Question: Write the caption for this figure.
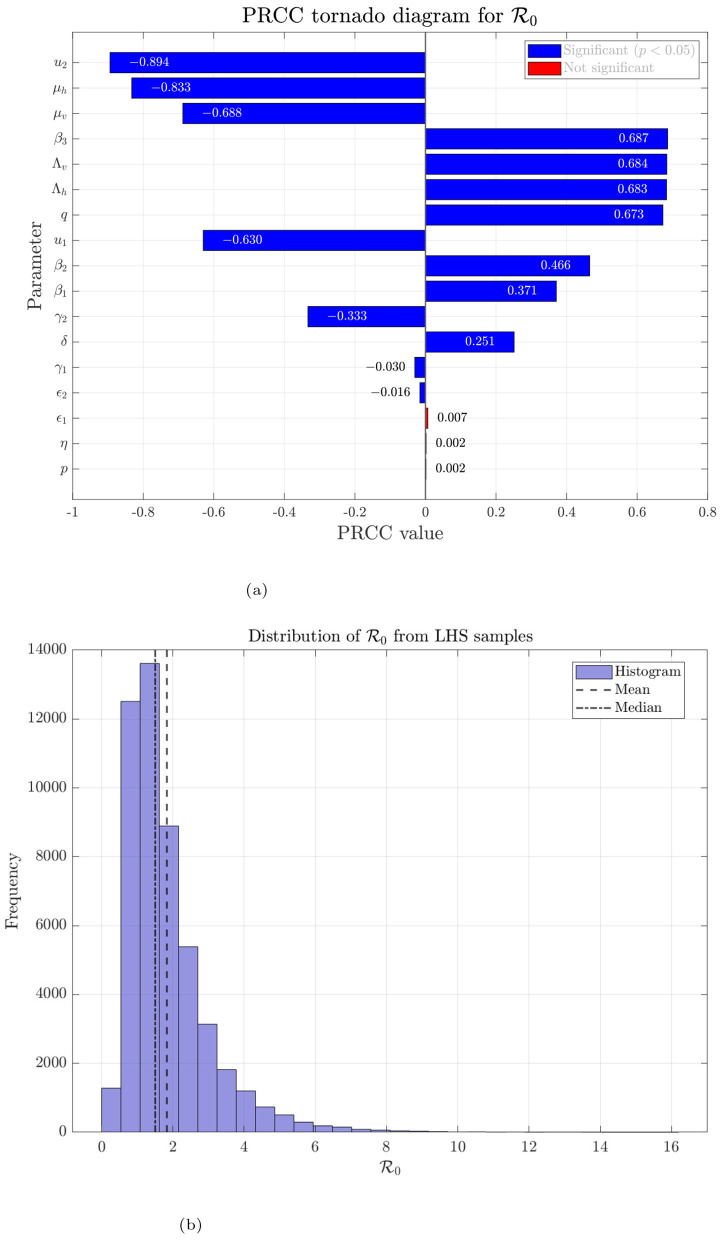
Answer: Numerical results for a global sensitivity of R 0 . (a) PRCC analysis results of R 0 . (b) Distribution of R 0 values from LHS sampling.